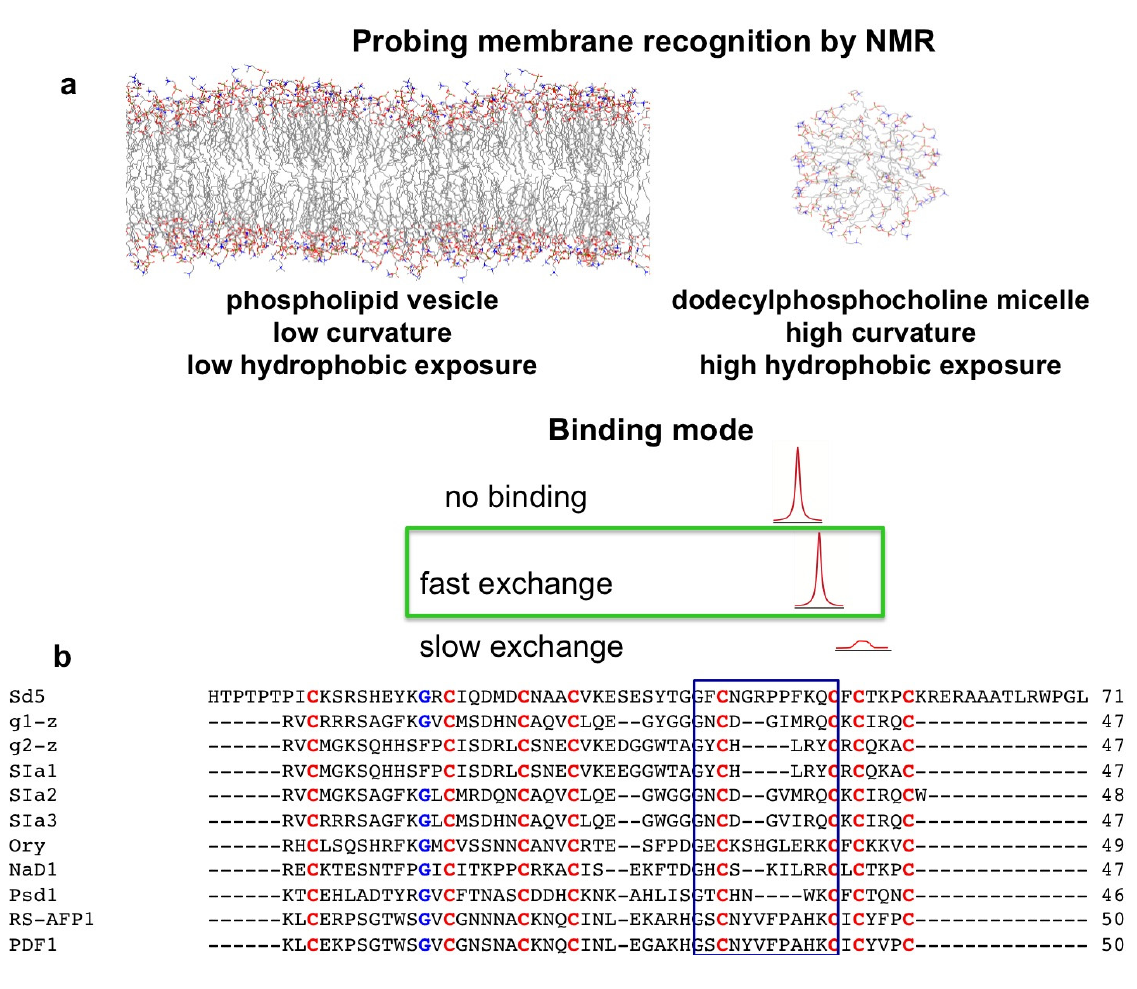
Figure 2. Common membrane mimetic systems and sequence alignment of plant defensins used in this study to probe events of membrane recognition. The resulting NMR spectrum of a given nucleus depends on the affinity of the membrane-defensin complex. In a fast exchange regime, the spectrum exhibits sharp lines. If the interaction is too strong (high affinity complexes), the spectrum exhibits broad NMR lines ( a ). Comparison of the primary sequence of representative plant defensins. Conserved cysteine residues are colored in red and the conserved glycine residue is highlighted in blue. The γ -core motif (GXC or CXG-C) is indicated by a blue box [61] ( b